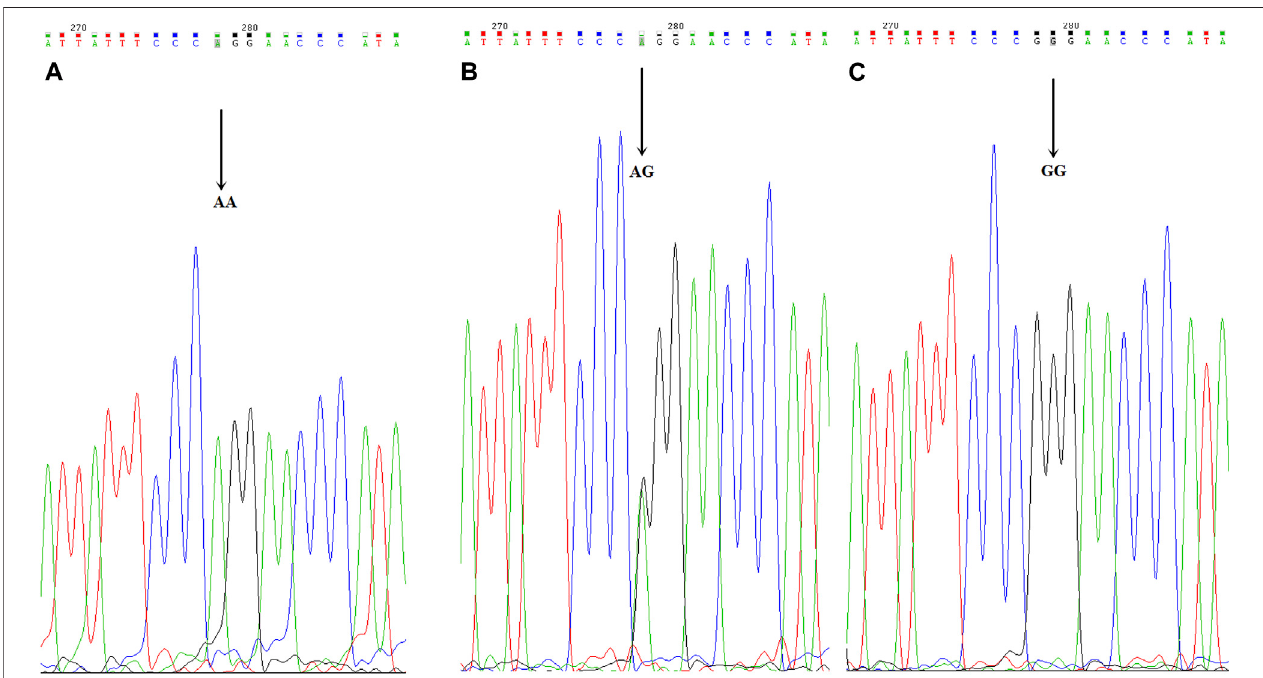
FIGURE3| CYP2C19*2mutantallelicvariantmap.ABCisthemutationsequence,andthearrowshowsthemutationsite(AA/AG/GG),whereAA/AGisthemutant gene.